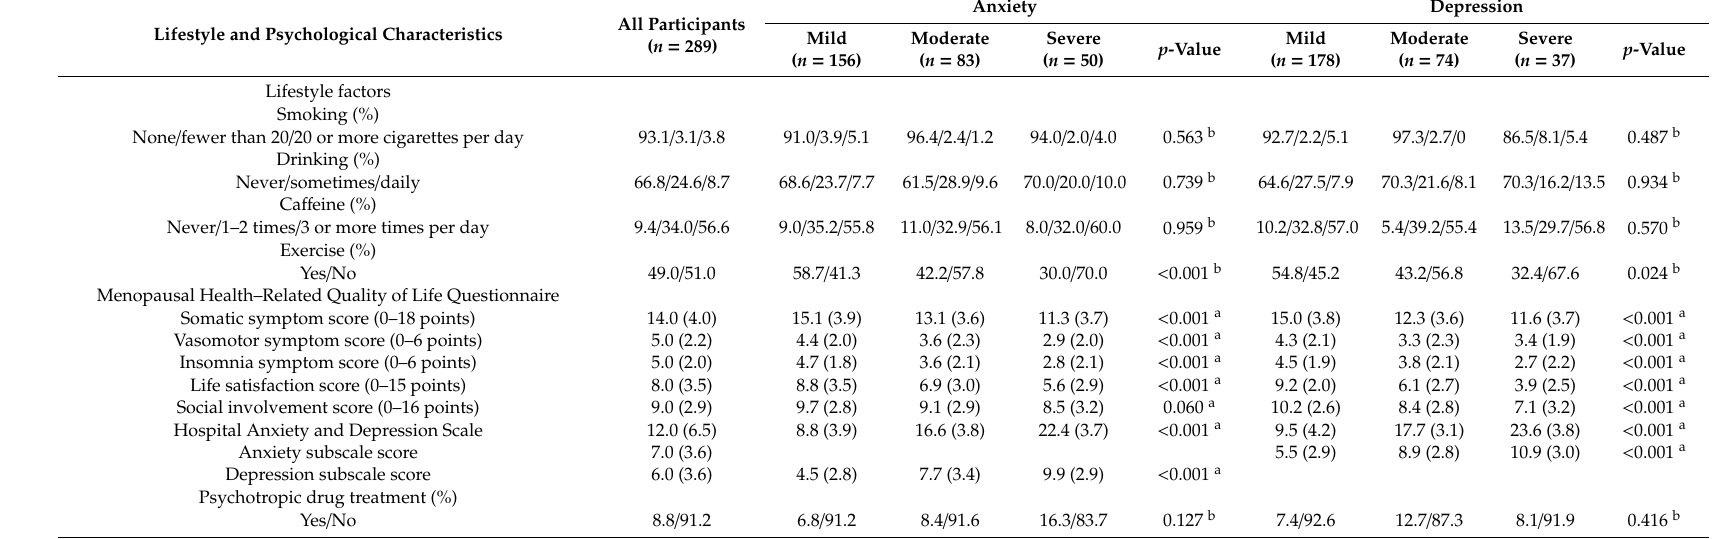
Table 2. The lifestyle and psychological characteristics of all the participants and comparison of these factors between women with mild, moderate, and severe anxiety and depressive